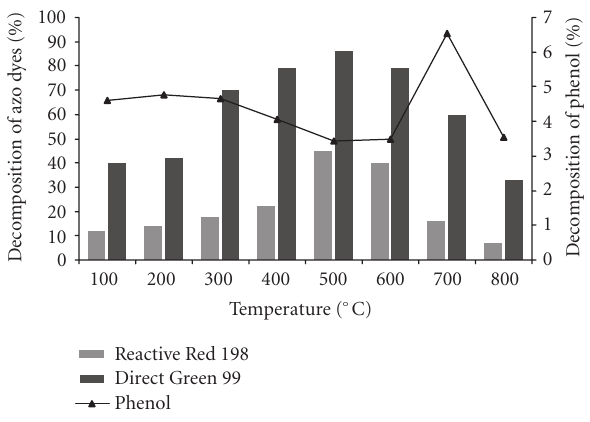
Figure 4: Photocatalytic decomposition of azo dyes and phenol under visible light on studied TiO 2 /N sample.